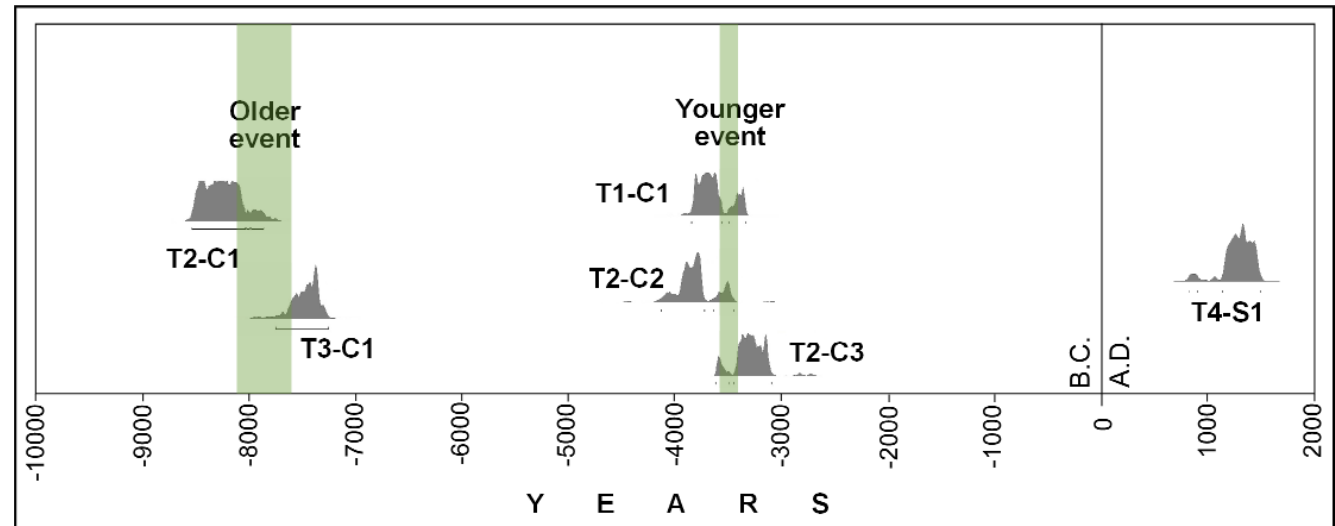
Figure 13. Probability distribution of calibrated 14 C ages obtained from sequential radiocarbon dates. Measurements were calibrated by OxCal, version 4.1.7 [Bronk Ramsey 2009], in which the atmospheric correction curves were those of Reimer et al.